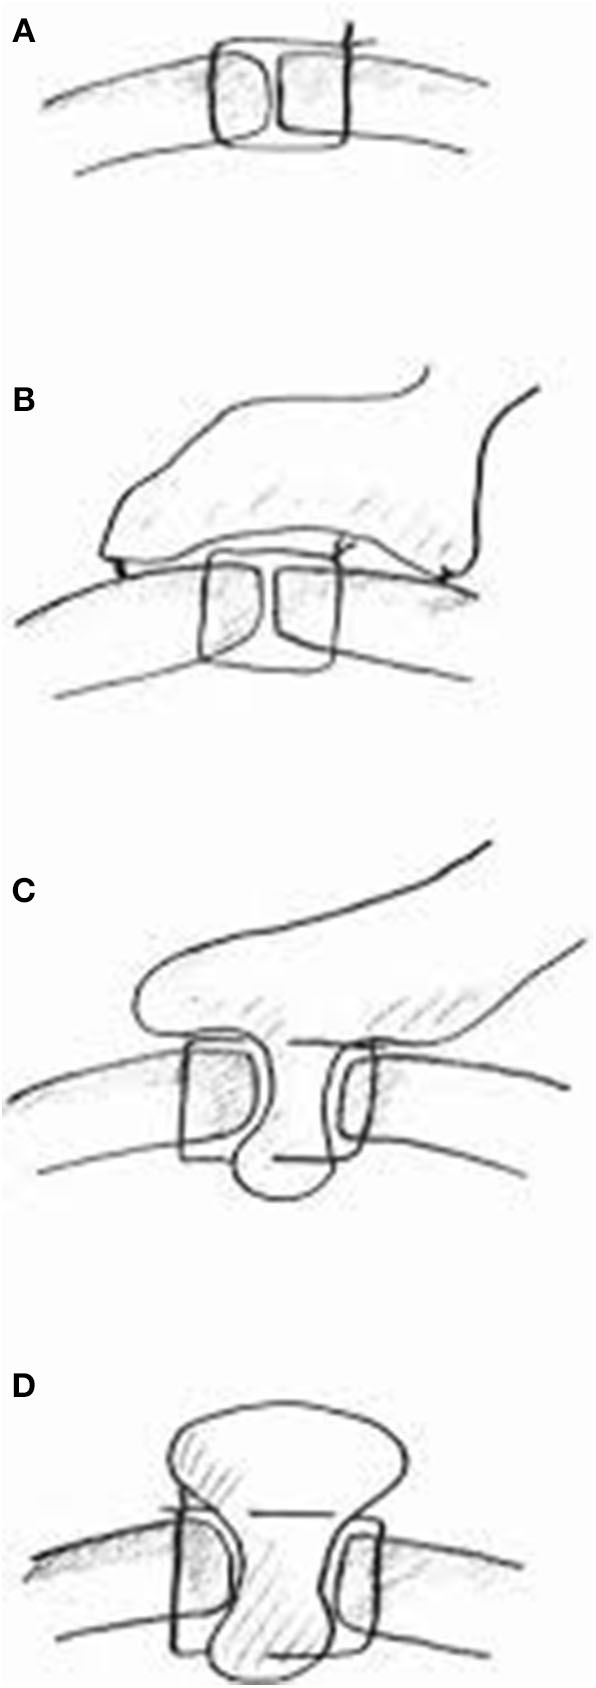
Summary of different suture techniques for closure of perforation [From above: (A) primary closure by interrupted sutures, (B) primary closure by interrupted sutures covered with pedicled omentopexy, (C) Cellan-Jones repair-plugging the perforation with pedicled omentoplasty, (D) Graham patch-plugging the perforation with free omental plug; with permission Bertleff and Lange (1)].